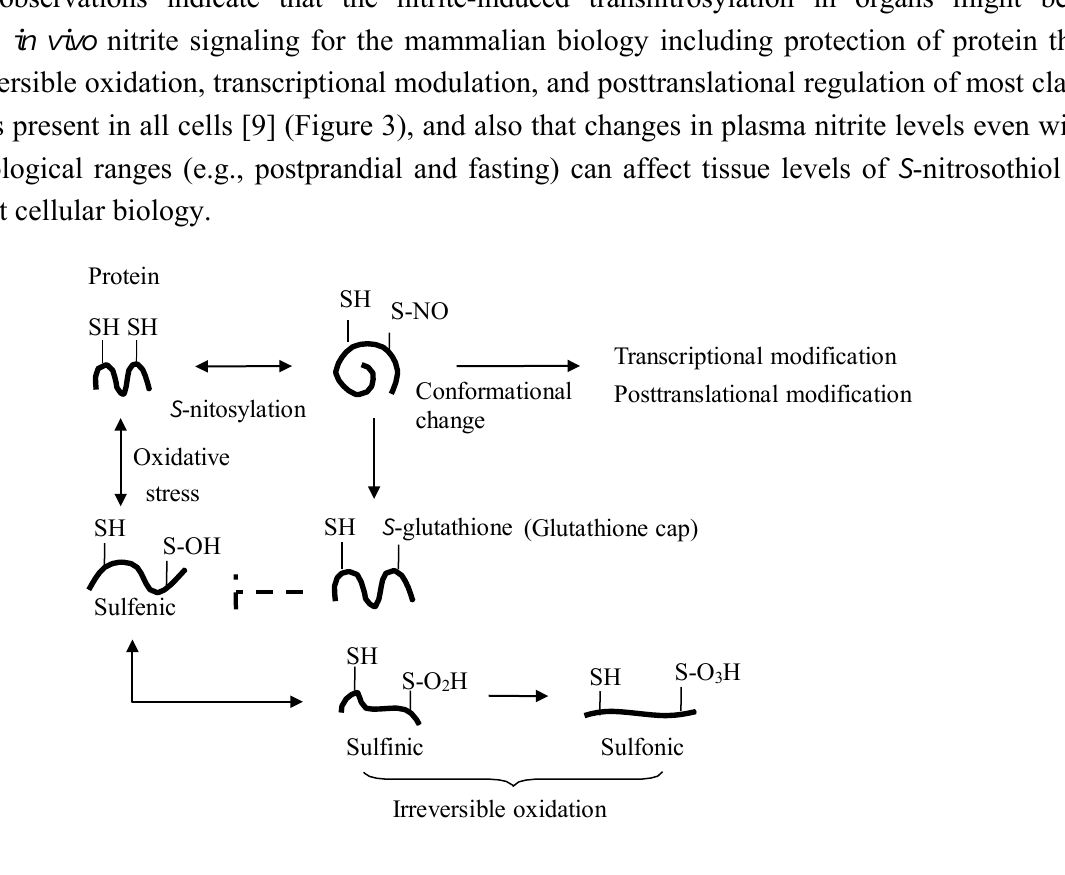
Figure 3. Protein S -nitrosylation. S -nitrosylation of protein elicits its regulatory